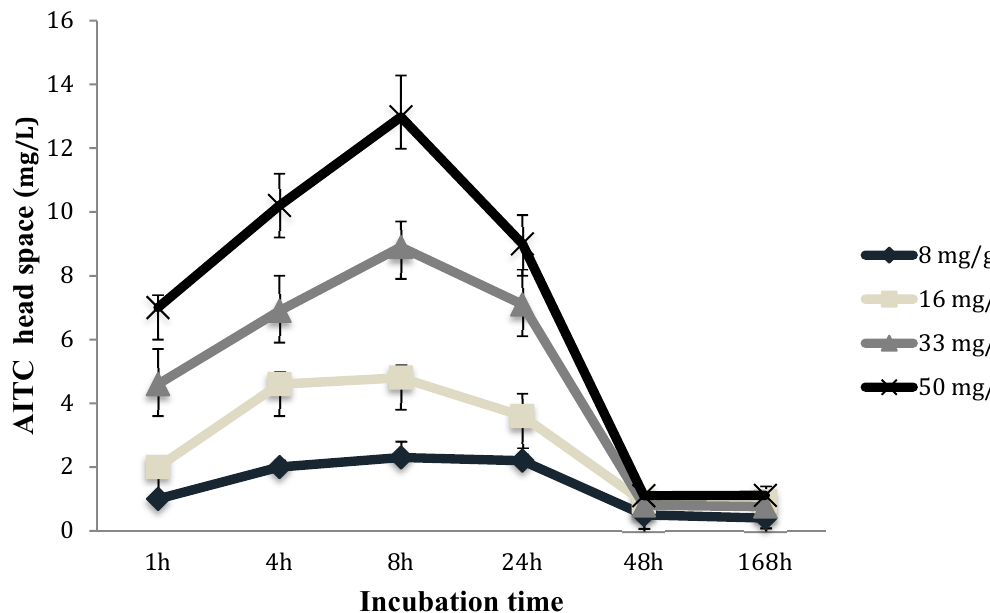
Figure 1. Volatilization kinetics of the AITC contained in the plastic trays produced through the sinigrin conversion obtained from 8, 16, 33 and 50 mg/g of oriental mustard flour incorporated in the bioactive sauce.